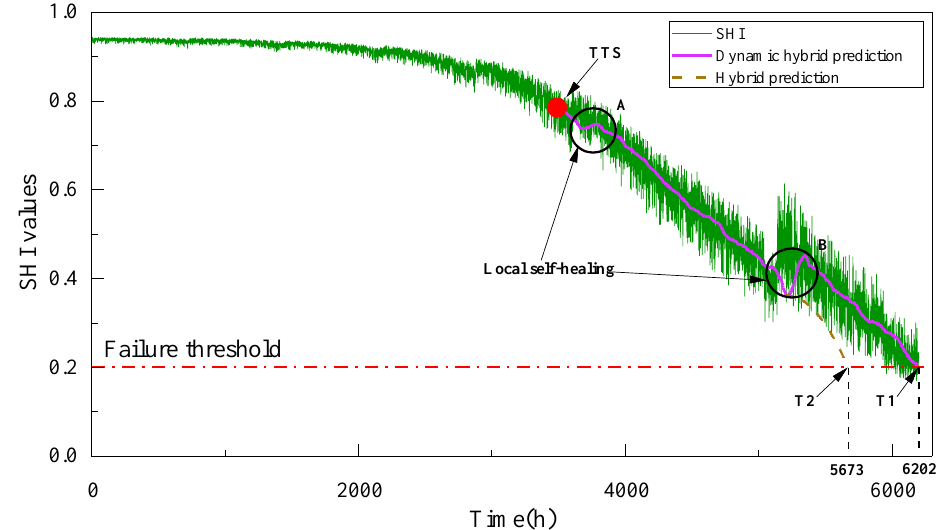
Figure 11. Change of system health condition for interference state.